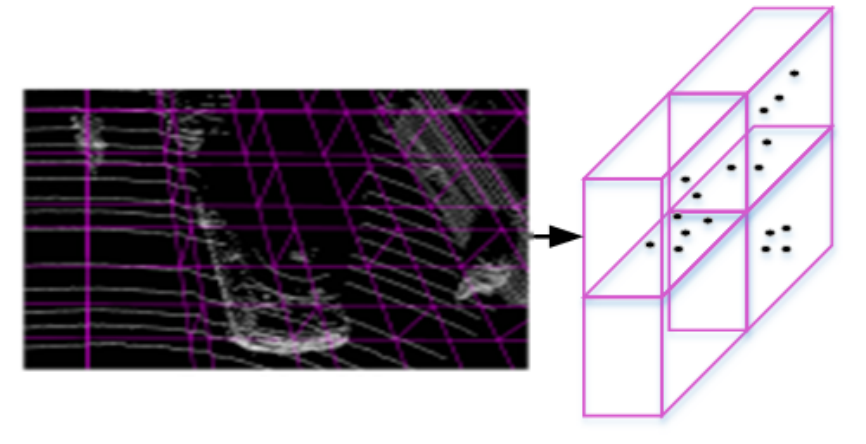
Figure 12. Voxelization of a point cloud.